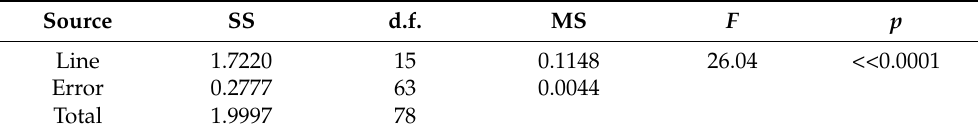
Table 1. ANOVA on the log e -transformed fitness estimates of 16 ampicillin-resistant lines, each measured relative to its sensitive parent.